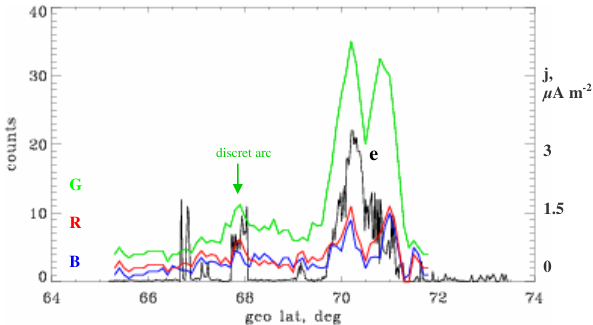
turbations along each radar beam. Colour represents the HF power.